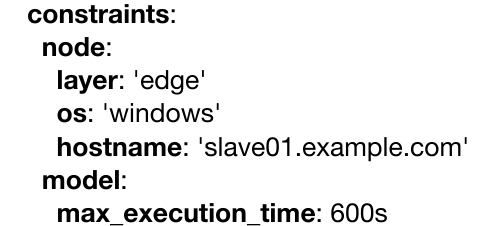
Figure 7. Example of the constraints keyword.